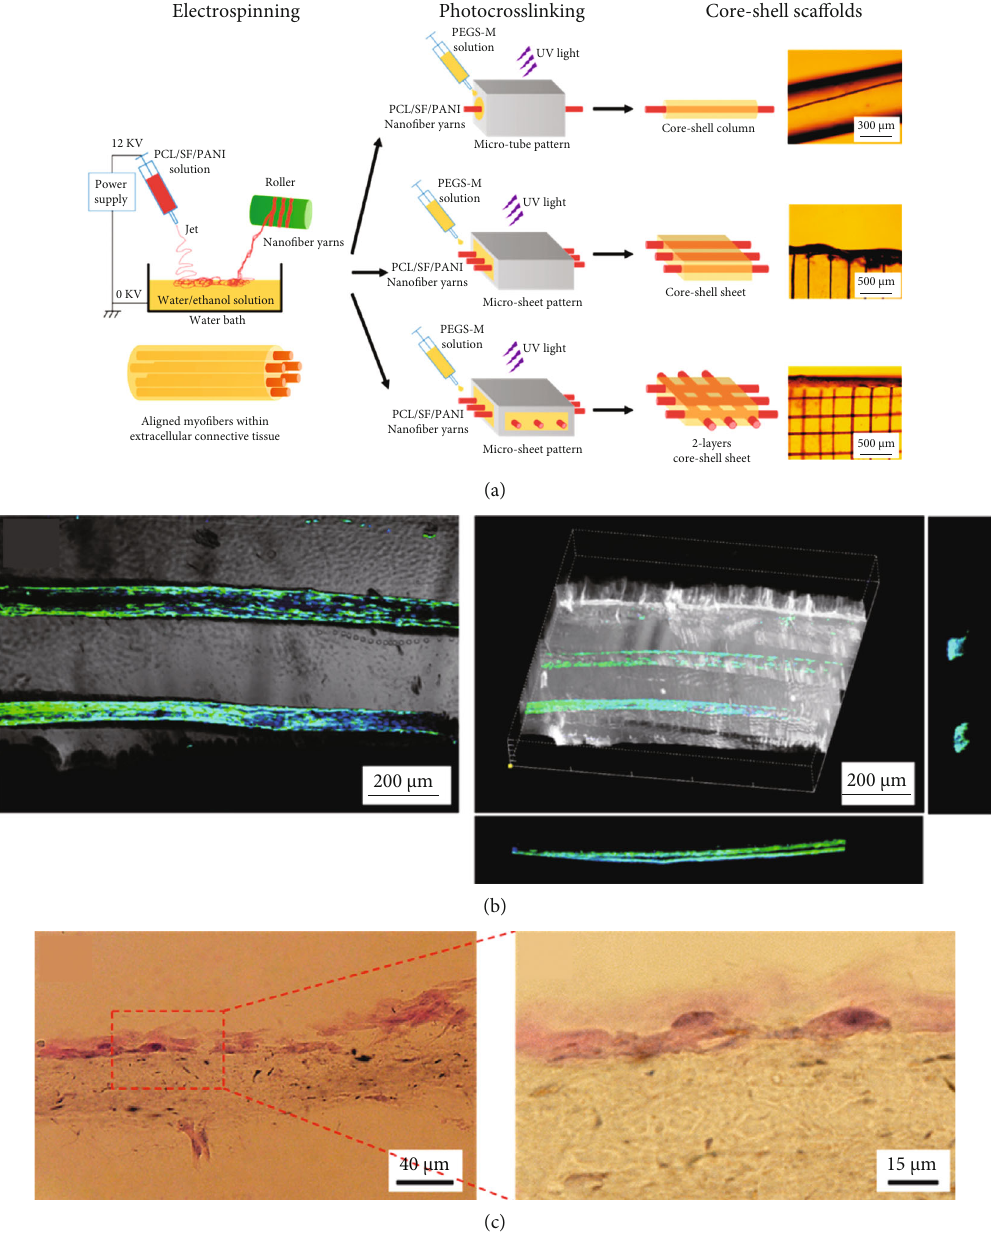
Figure 7: Nano fi ber yarn/hydrogel composite 3D sca ff olds for myoblast alignment and di ff erentiation. (a) Preparation illustration of yarn/hydrogel composite 3D sca ff olds with native skeletal muscle mimicking core-shell structure (aligned nano fi ber yarns by electrospinning and PEG-based hydrogel shell via photocrosslinking). (b) Highly organized C2C12 myotubes within the 3D hydrogel. (c) H&E staining images of the construct with C2C12 cell encapsulation after cultivation for seven days. Reproduced with permission from [133]. Copyright © 2015, American Chemical